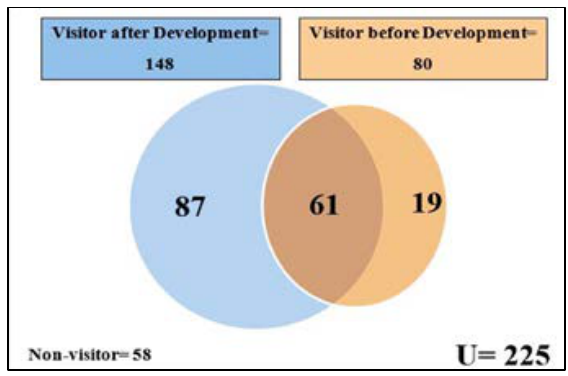
Fig. 3: Venn diagram of Frequency of Visitor and Non‐user